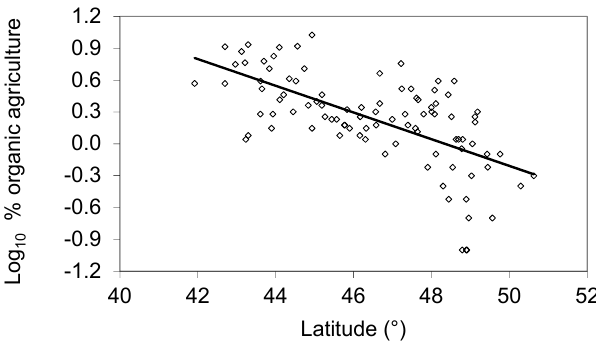
Figure 1. Latitudinal gradient of the proportion of agri- cultural land under organic farming (logarithmically trans- formed) in French departments (2008; n = 95, y = (cid:0) 0 : 125 x + 6 : 079 , R 2 = 0.40, p < 0.001).